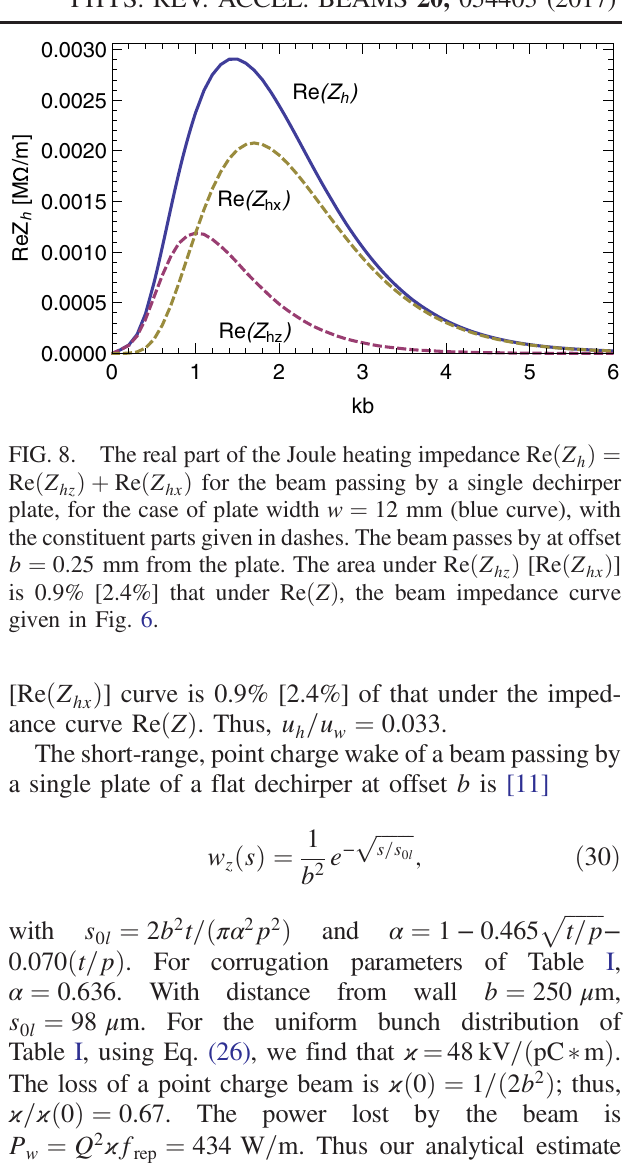
The loss of a point charge beam is ϰ ð 0 Þ ¼ 1 = ð 2 b 2 Þ ; thus, ϰ = ϰ ð 0 Þ ¼ 0 . 67 .